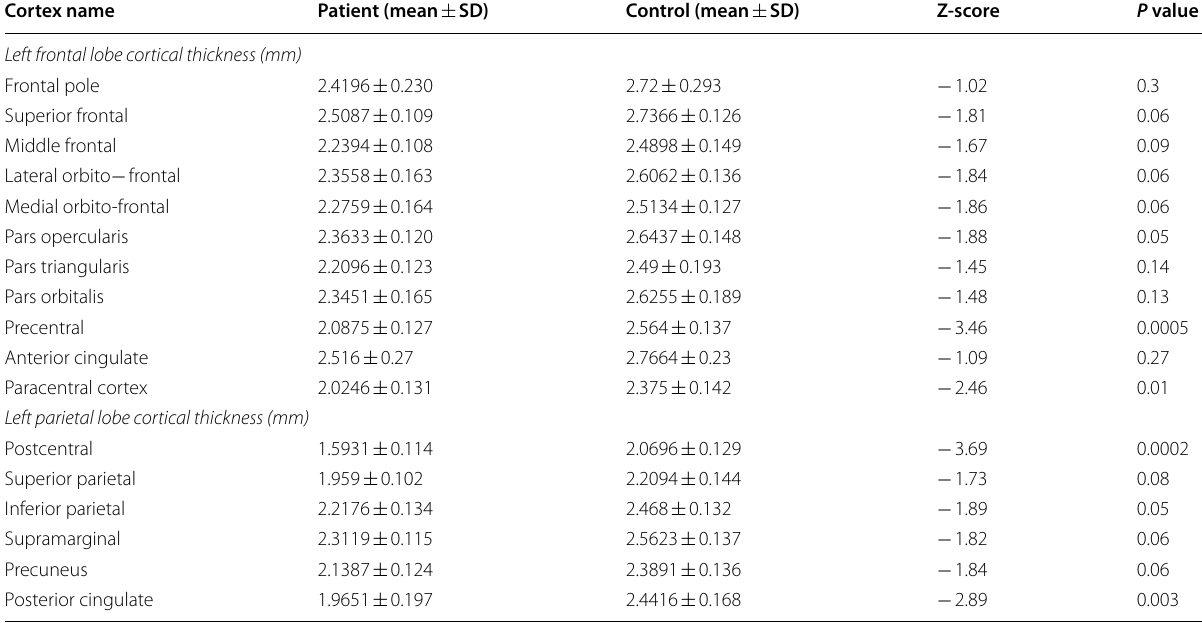
Table 3 Quantitative results of the cortical thickness in mm of the left frontal and parietal lobe areas in mm for patients and control groups, Z-scores and P values